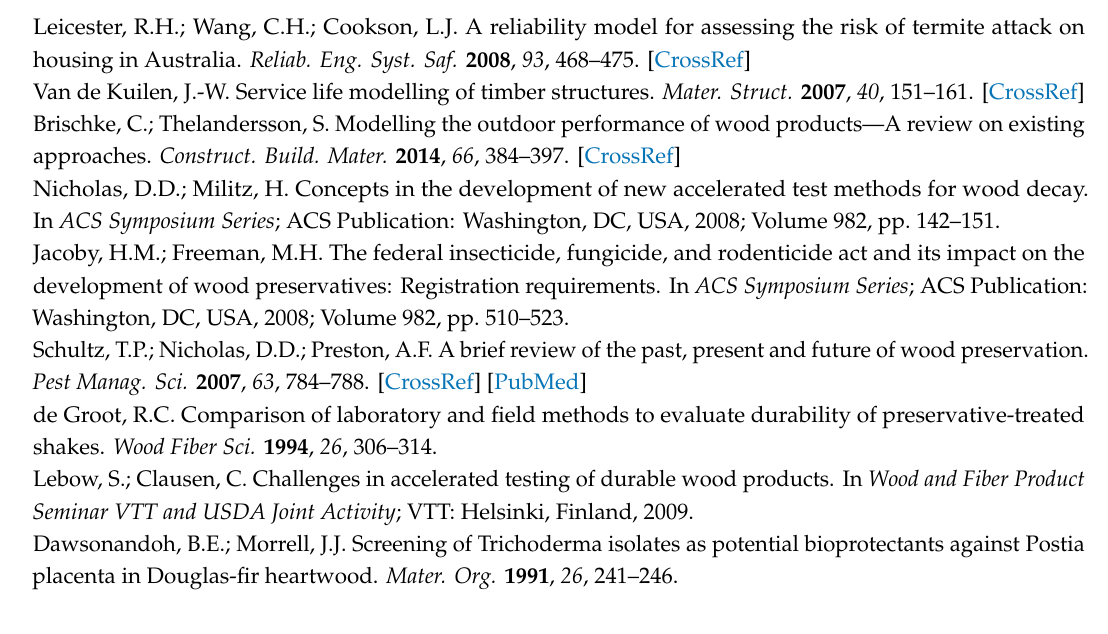
Figure S1: Decay scores in 2017 were predicted from a mixed-e ff ects regression (conditional on treatment as a random e ff ect; R 2 = 0.68, RMSE = 2.08), Table S1: Summary of Statistical